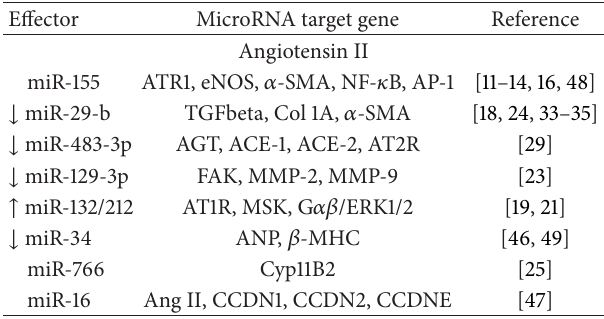
Table 1: MicroRNAs affected by RAAS